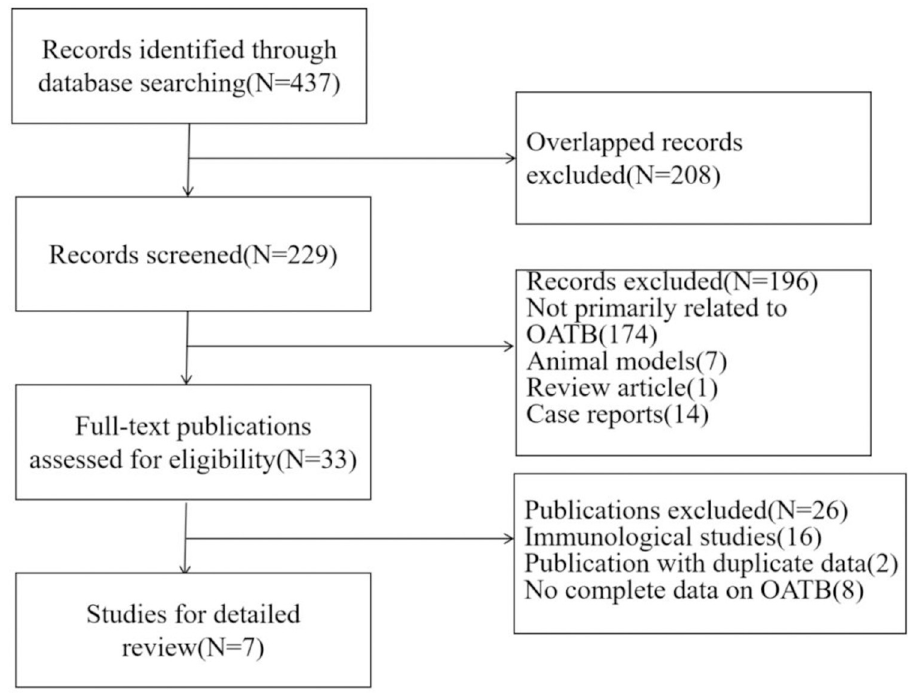
Fig 1. Flow chart of the study selection process. The flowchart shows the procedure used to select the articles for the qualitative and quantitative synthesis.